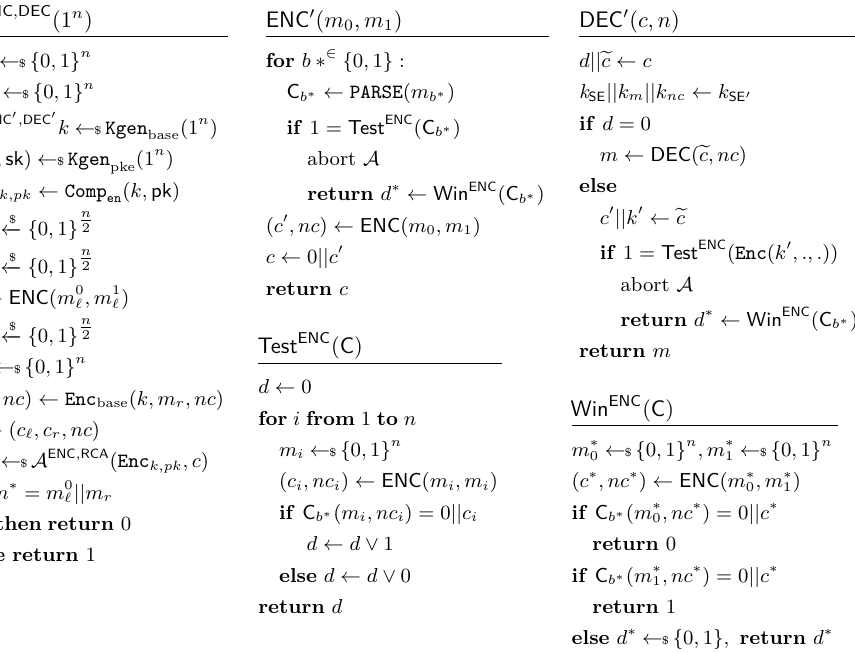
Figure 5: Description of adversary C A